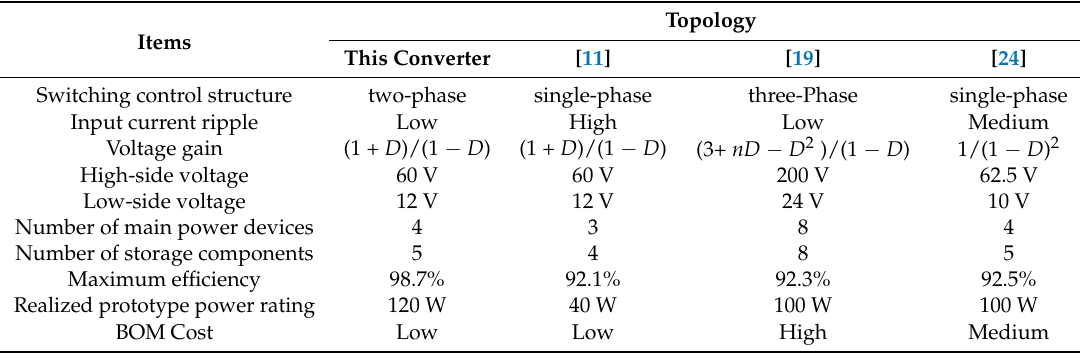
Table 6. Performance comparisons among other existing